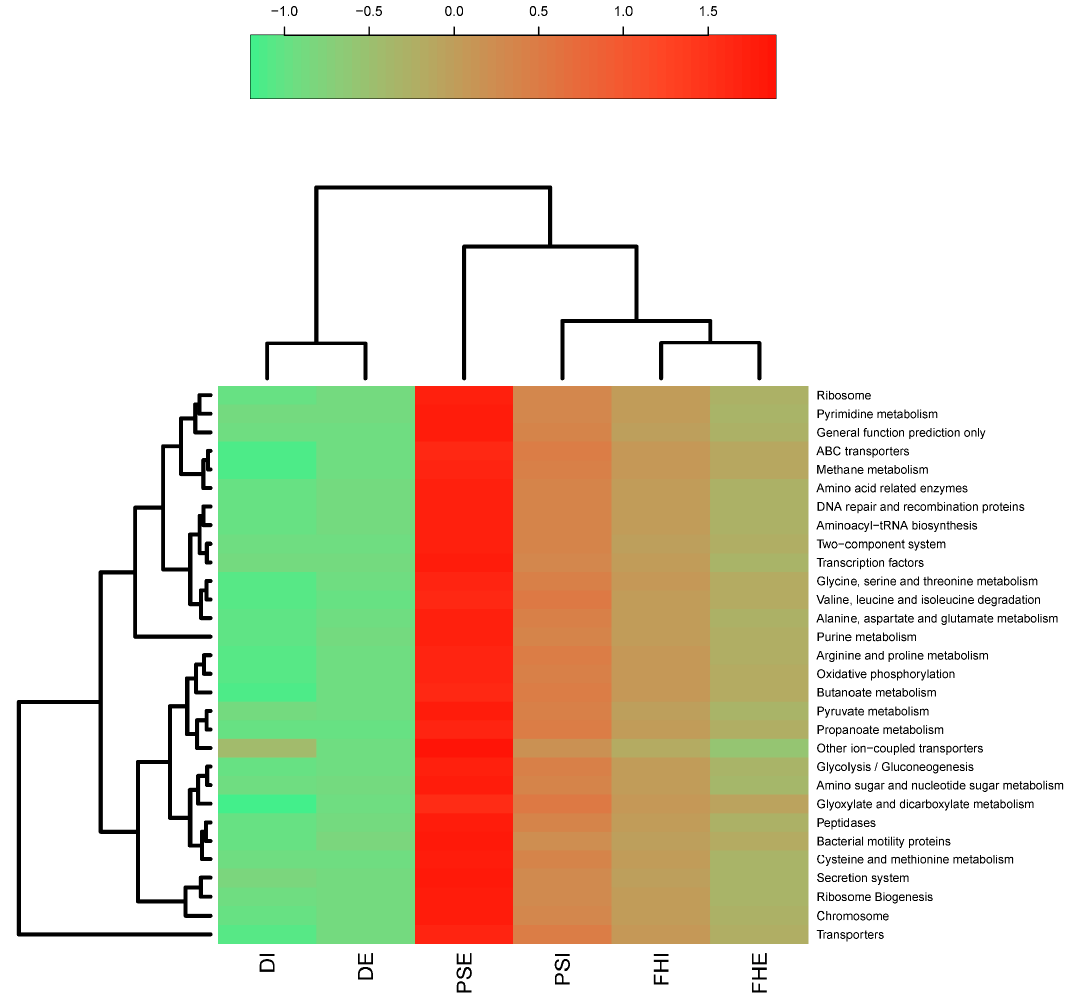
Figure 6. Heat map showing functional relative abundance in the WWTPs, predicted using PICRUSt (Phylogenetic investigation of communities by reconstruction of unobserved states)